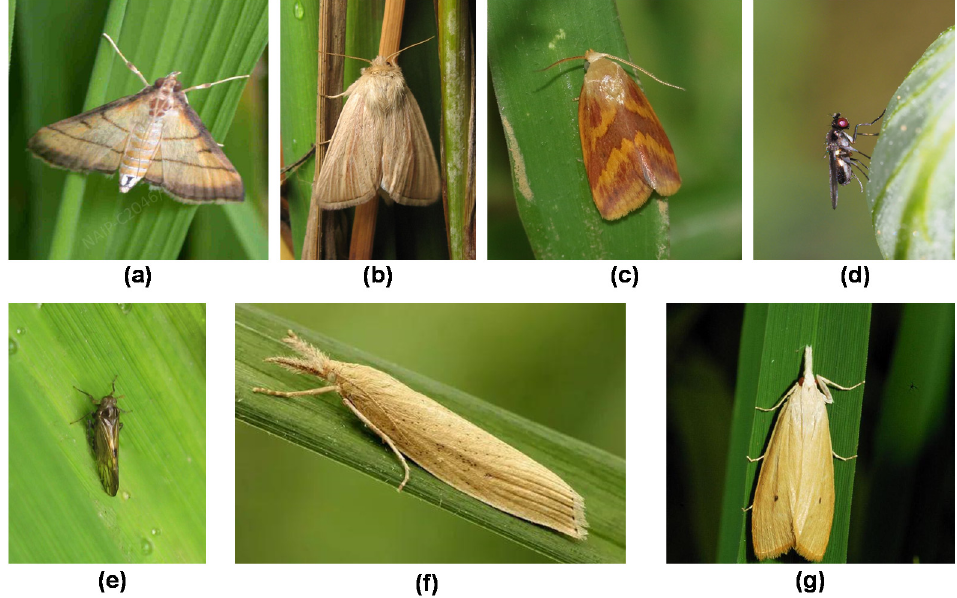
Figure 1. Samples of seven types of rice pests: ( a ) Rice leaf roller, ( b ) pink rice borer, ( c ) rice leaf caterpillar, ( d ) paddy stem maggot, ( e ) plant hopper, ( f ) Asiatic rice borer, ( g ) yellow rice borer.